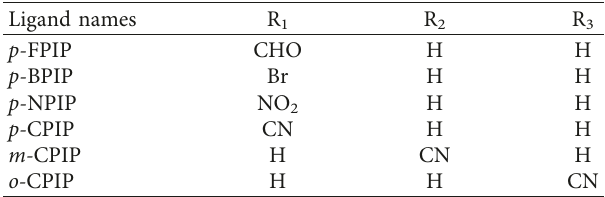
Figure 1: Ruthenium complexes: (a) [Ru(bpy) R groups being CHO, NO 2 , Br, and CN for the ligands, respectively. Table 1: R groups for each main polypyridyl